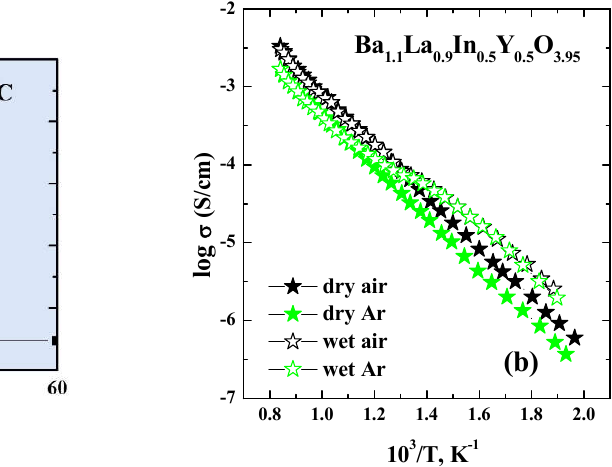
Figure 9. The resistance as a function of exposure time for the sample Ba 1.1 La 0.9 Y 0.5 In 0.5 O 3.95 obtained during switched from dry Ar to wet Ar atmosphere ( a ), and the temperature dependencies of conductivities for the composition Ba 1.1 La 0.9 Y 0.5 In 0.5 O 3.95 obtained under dry (open symbols) and wet (filled symbols) air (black symbols) and Ar (green symbols) (b).